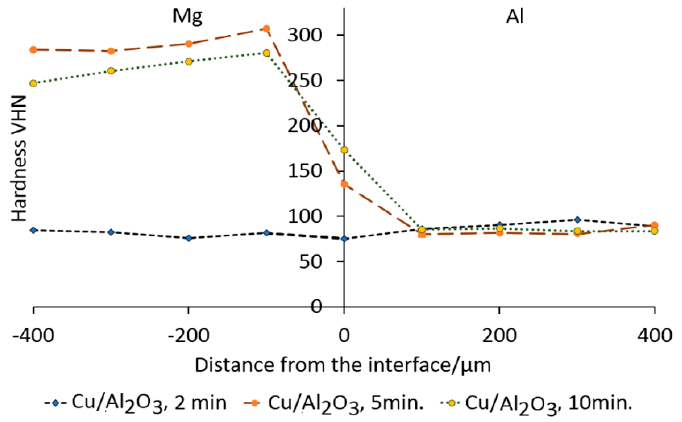
Figure 12. Micro-hardness profile for Mg/Al bonds as a function of bonding time using Cu/Al 2 O 3